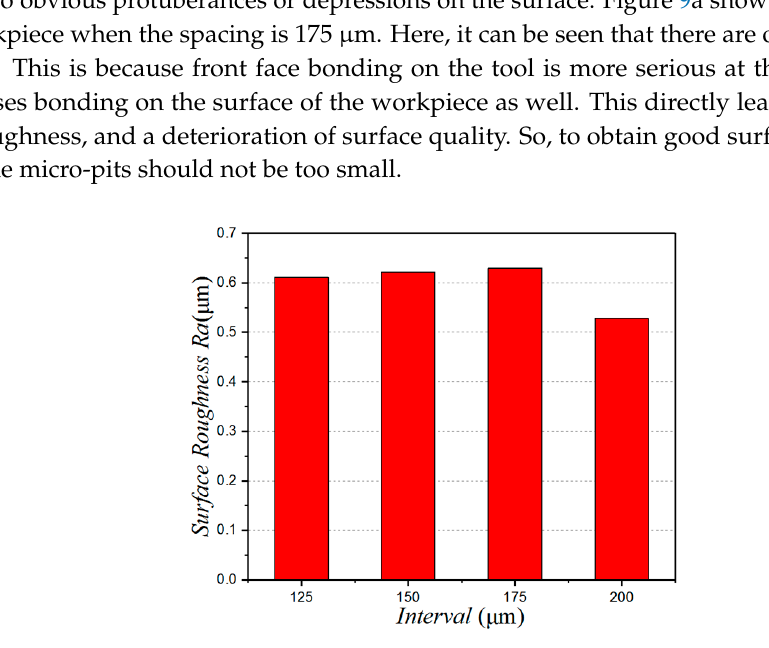
Figure 9. Workpiece surface morphology. ( a ) 175 μ m; ( b ) 200 μ m.